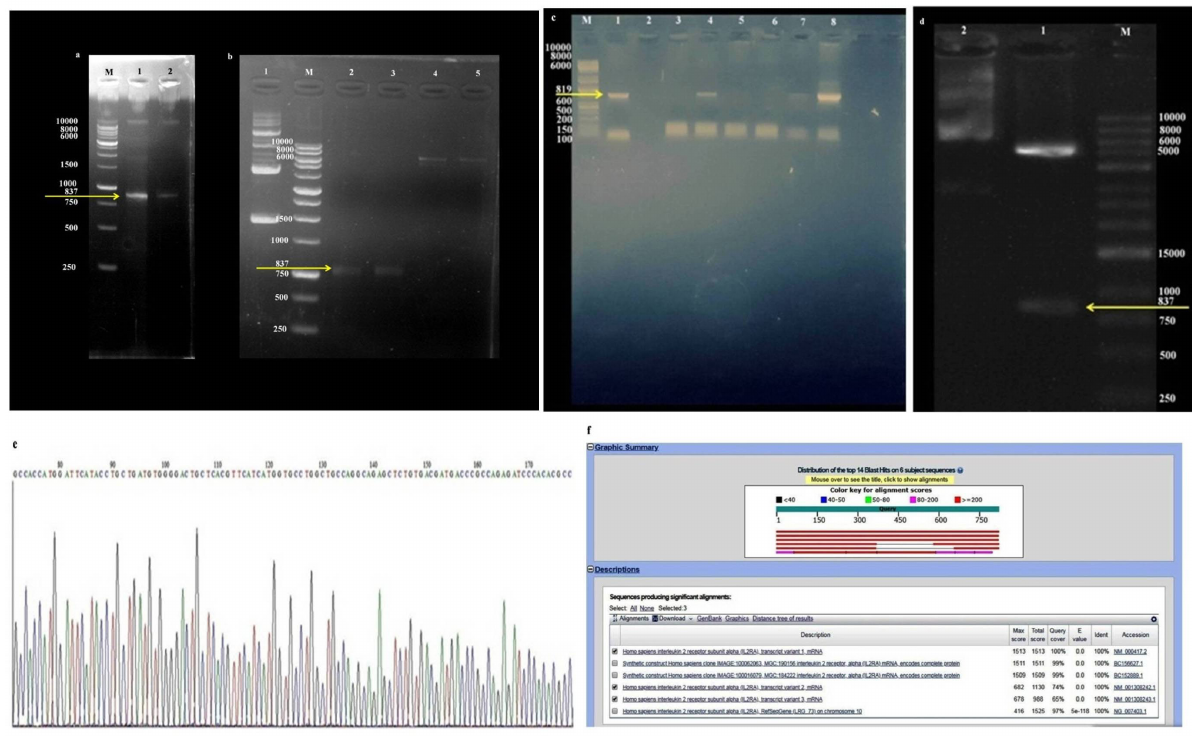
Figure 3: (a) Due to the unspecific bands from previous PCR step, the extra gel purification was performed to excise and purify the band of CD25 coding sequence based on the selected annealing temperature of 60°C. The well was marked by “M” referred to GeneRuler 1Kb DNA Ladder (Thermo Fisher Scientific Inc., MA, USA). Also, the wells were marked by the numbers of 1 and 2 referred to the different concentrations of excised band from two repeats. (b) Digested pcDNA3.1(+) plasmid and specific cDNA fragment of CD25 by Hind III